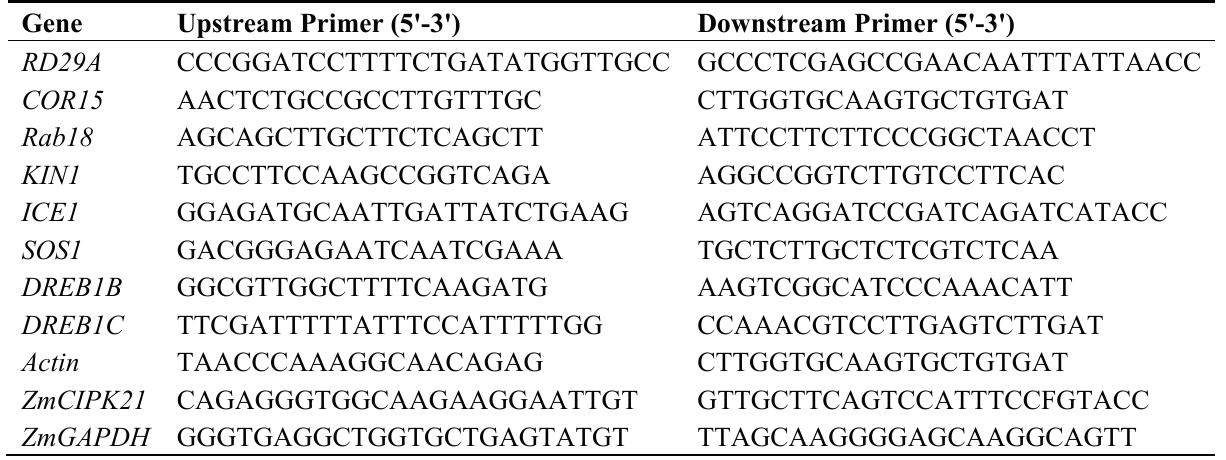
Table 1. Primers used for quantitative PCR